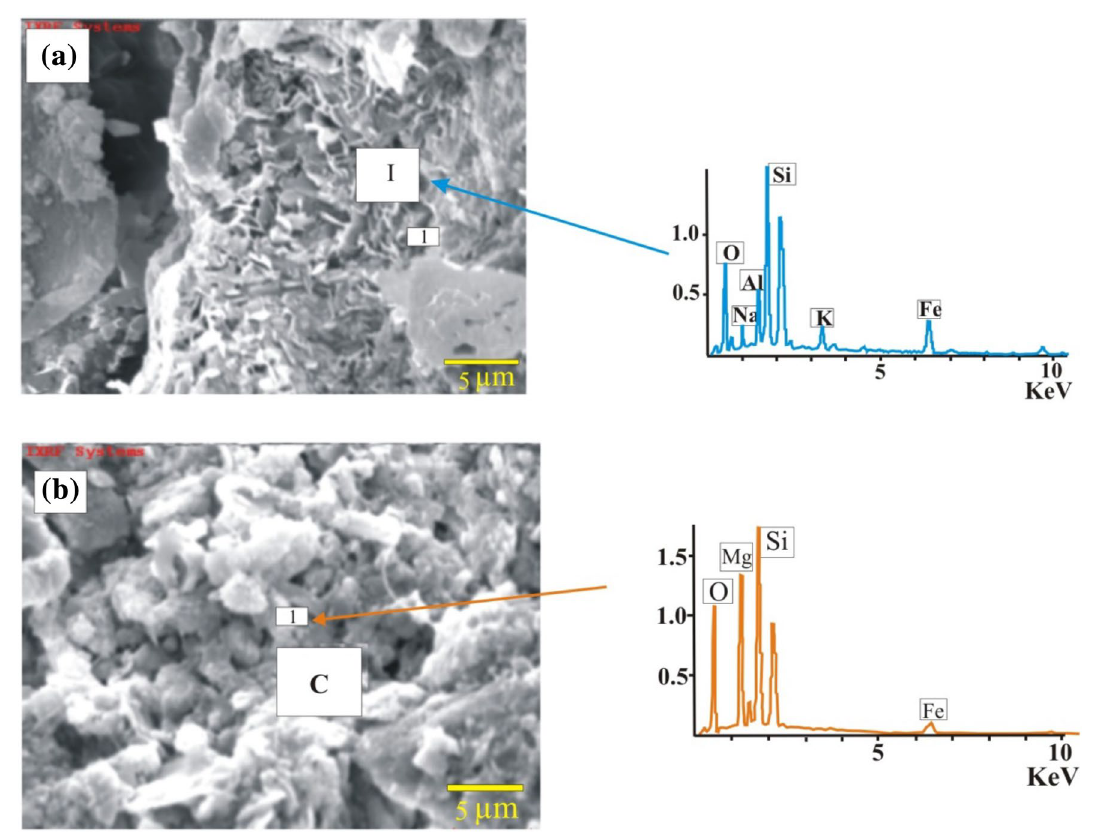
b Chlorite (C) minerals are seen as a flake morphology in the SEM micrographs. Dominant chlorite (C) peaks are Mg elements in the